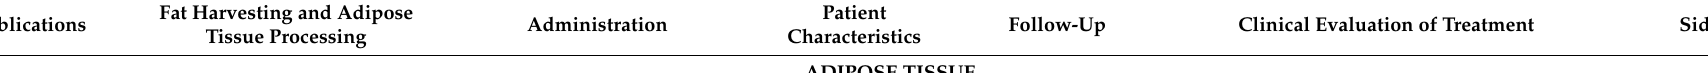
Table 1. Studies evaluating autologous fat-grafting and adipose-derived cell therapy products for the treatment of face involvement in